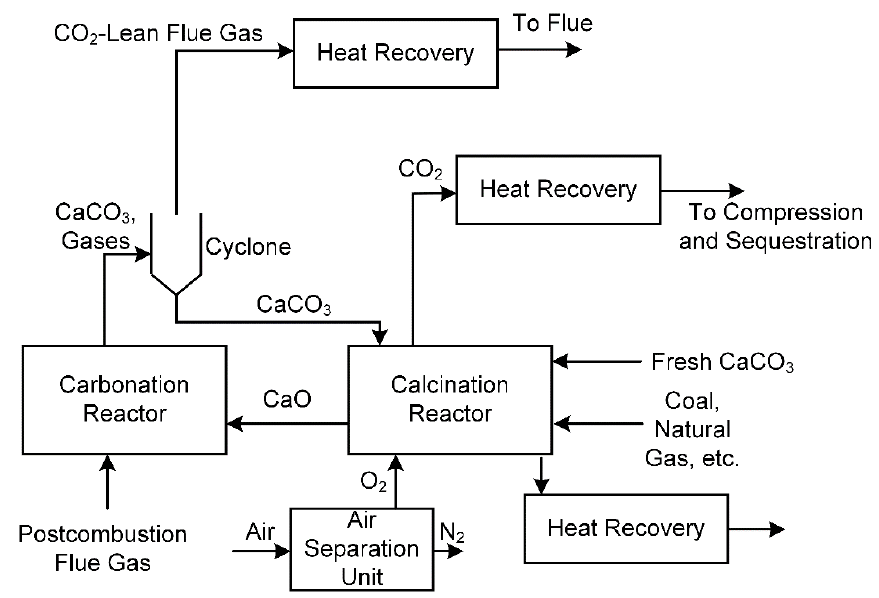
Figure 8. An example calcium looping process for post ‐ combustion CO 2 capture.